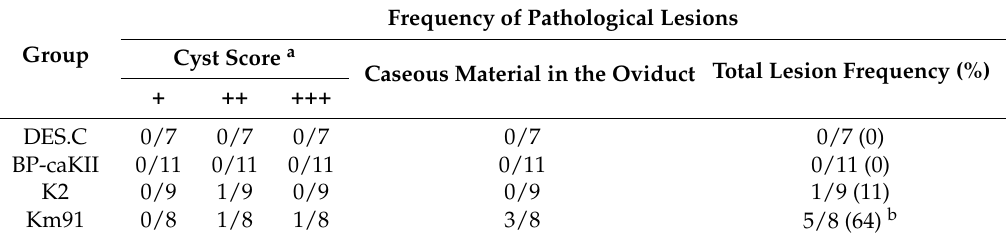
Table 4. Gross lesion scoring of reproductive organs of IBV by the diethylstilbestrol (DES)-treated oviduct